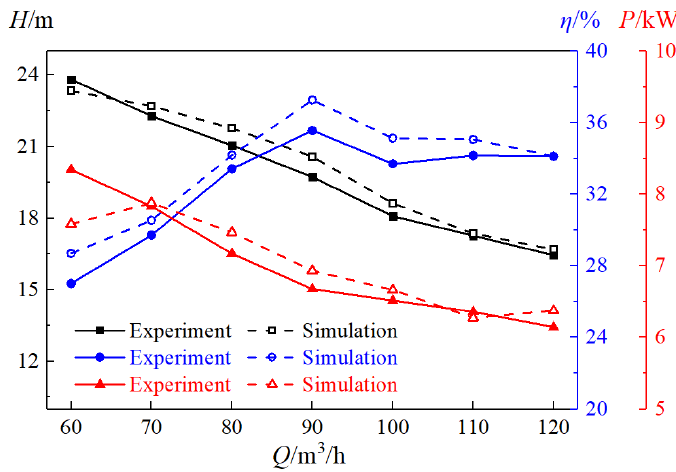
Figure 6. Comparison of external characteristics of the experiment and numerical simulation.